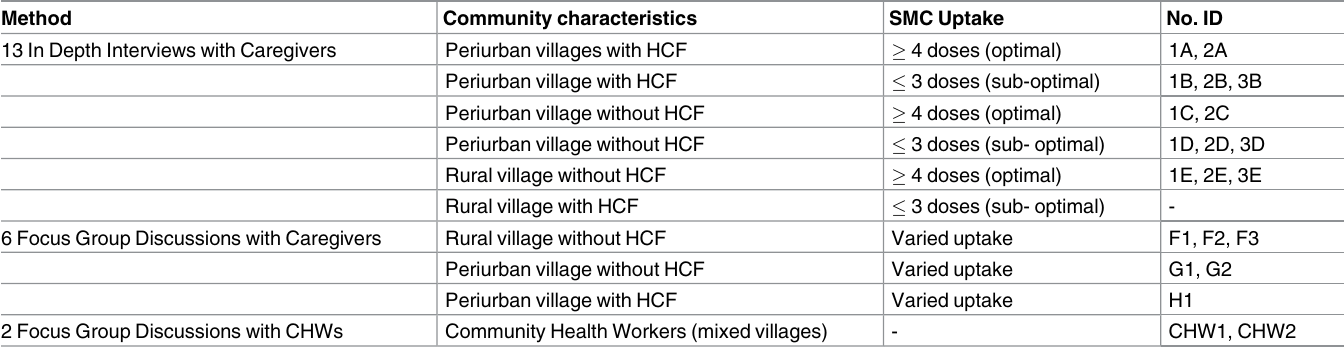
Table 1. Female caregivers and community health workers who took part in In-Depth Interviews or Focus Group